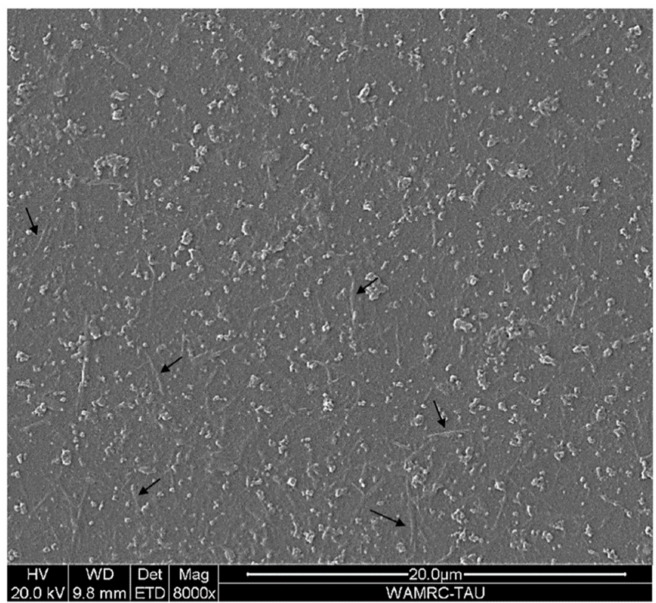
Figure 8. SEM imaging of the obtained NC particles (size bar is 20 µ